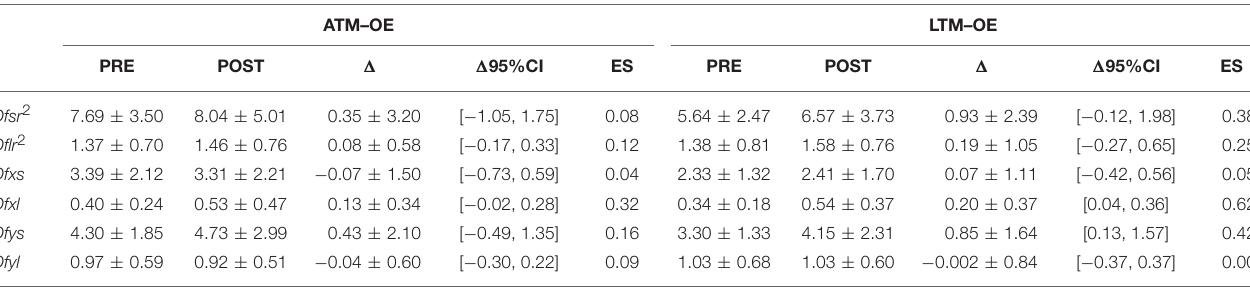
TABLE 3 | Stabilogram diffusion analysis results in the OE condition.